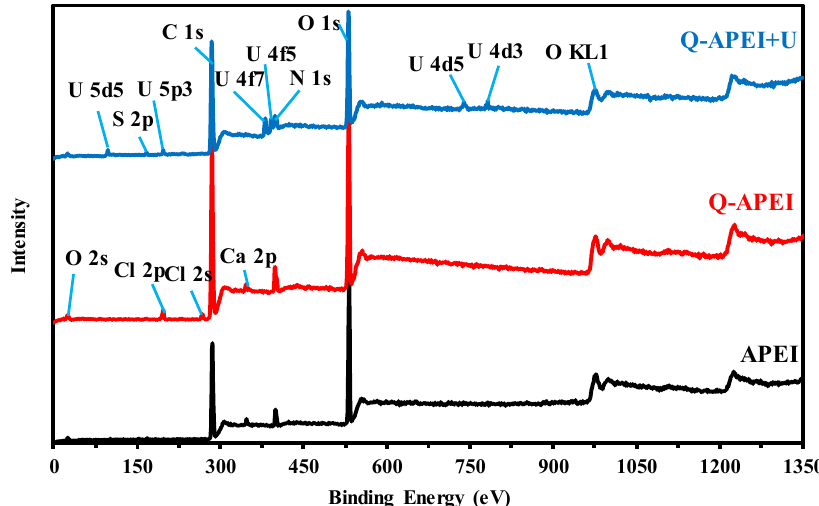
Figure 2. XPS survey of raw material (APEI), after modification (Q-APEI), and after uranium sorption (Q-APEI-U).